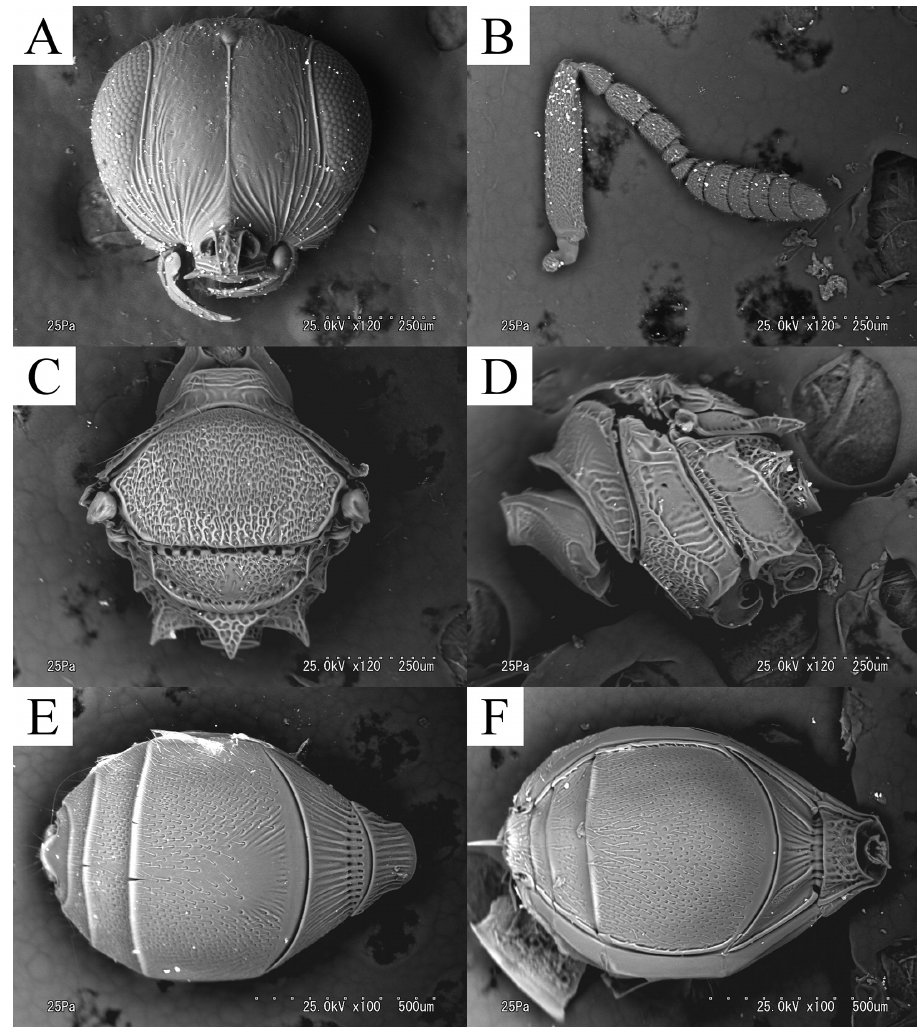
Figure 7. Trimorus haniyasu sp. n., female. A head, frontal view B Antennae C mesosoma, dorsal view D mesosoma, lateral view E metasoma, dorsal view F metasoma, ventral